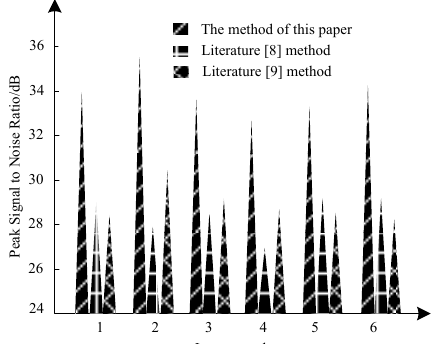
Figure 6. Comparison results of peak signal-to-noise ratio